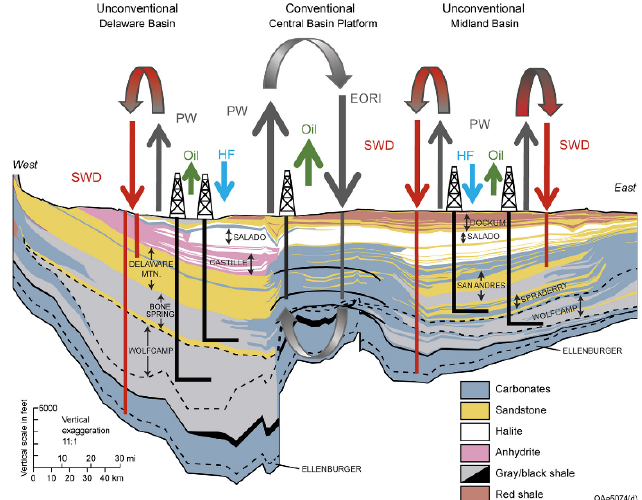
Figure 3. East-west cross-section of geological layers for Permian Basin reservoir [47]. Reproduced from Scanlon et al., 2017 (ref. [47]). Copyright 2017 American Chemical Society. (Blue arrows indicate water injection for hydraulic fracturing (HF). These arrows were used to represent the production data and estimate the relative volumes of the produced water.).